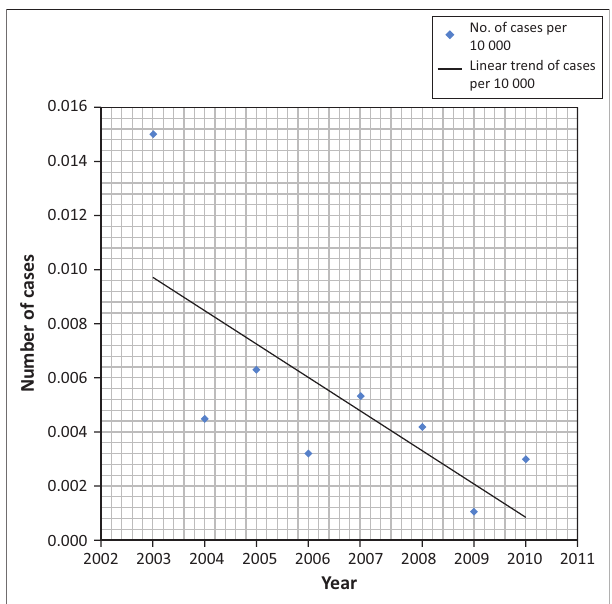
FIGURE 3: Prevalence rate of leprosy in Rwanda from